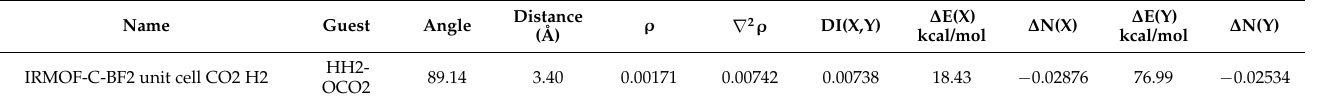
Table 10. Topological parameters of the BCP of bond in adsorption configurations of guest molecules (CO 2 , H 2 O, and H 2 ) on unit cell IRMOF-C-BF 2 . Guest intermolecular